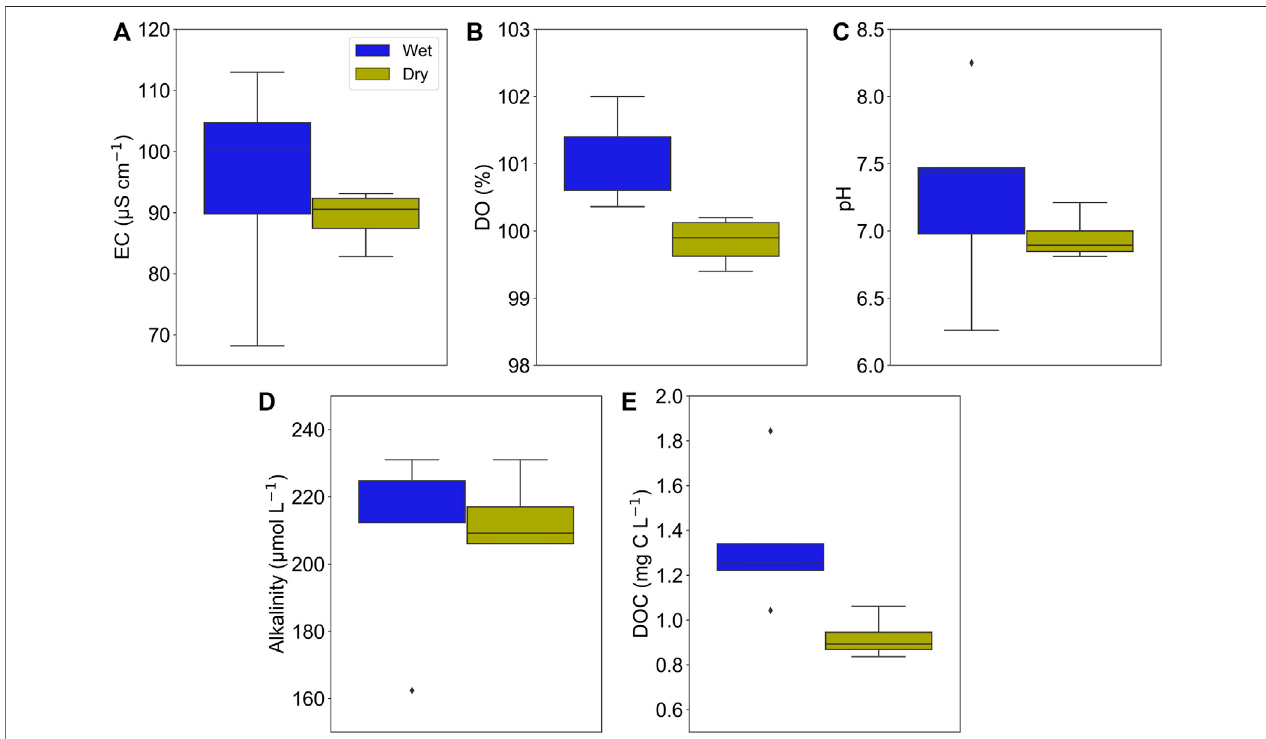
FIGURE 3 | Boxplots summarizing the water quality variables (EC, DO, pH, alkalinity, and DOC) of site G between wet and dry season.